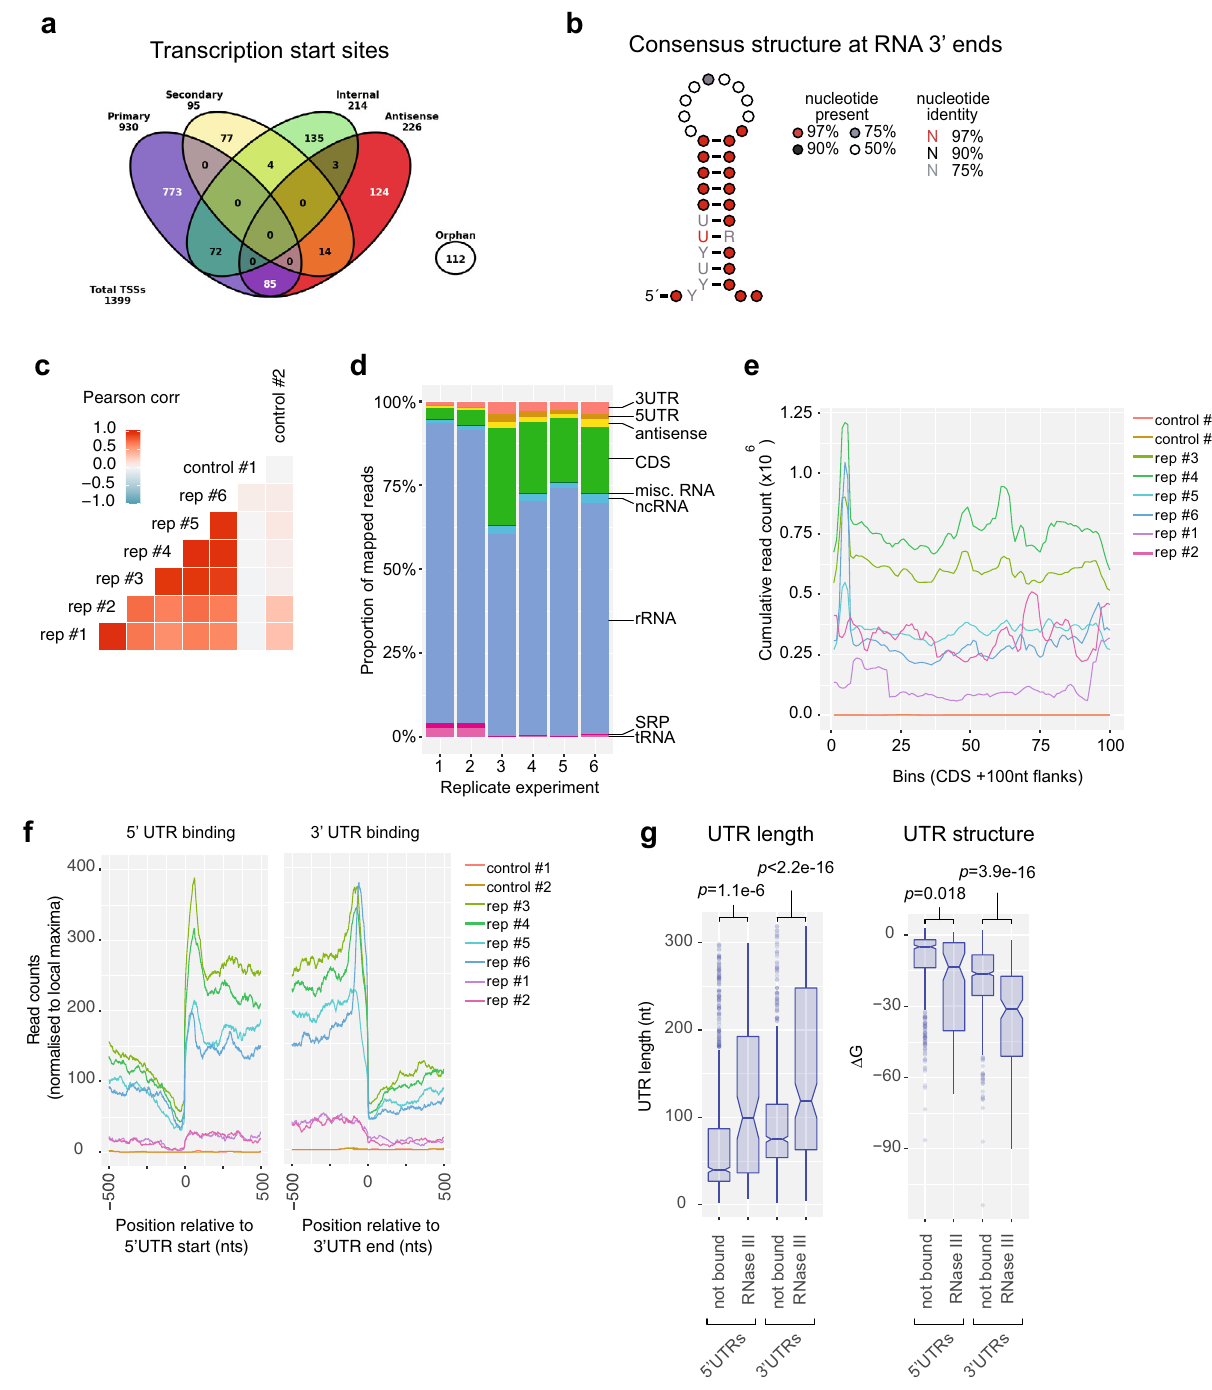
Fig. 1 RNase III interactions with the ANNOgesic annotated S. aureus JKD6009 transcriptome. a Transcription start sites and putative promoter regions identi fi ed through the ANNOgesic work fl ow. b The consensus 10-nt stem-loop RNA structure identi fi ed within our RNA 3 ′ boundary ends. Nucleotides are represented as coloured dots specifying the nucleotide percentage identify. c Heatmap showing the two-sided Pearson ’ s correlation between replicate RNase III CRAC datasets. d Proportion of RNase III-bound reads mapping to genomic features for replicate datasets. e Cumulative count of RNase III-bound reads mapping across CDSs. Each CDS was divided into 100 bins and the read depth within each bin is indicated. f Cumulative count of RNase III-bound reads mRNA 5 ′ UTR ends and 3 ′ UTR ends. Read counts for each individual UTR were normalised to 1 to prevent biases from abundant sites. The read count represents the cumulative normalised read count at 5 ′ and 3 ′ UTRs. g Distribution of RNase III-bound ( n = 104) and not bound ( n = 1052) UTR lengths (nts) ( left ) and structure (expressed as the free energy of the folded UTR, kcal/mol) ( right ). UTRs were classi fi ed as RNase III-bound if they contained >10 reads in two independent experiments. p- values were calculate using a two-sided t- test. For each boxplot, centre represents the median, box minima and maxima represent the 25th and 75th percentile respectively, and whiskers represent 1.5× the interquartile